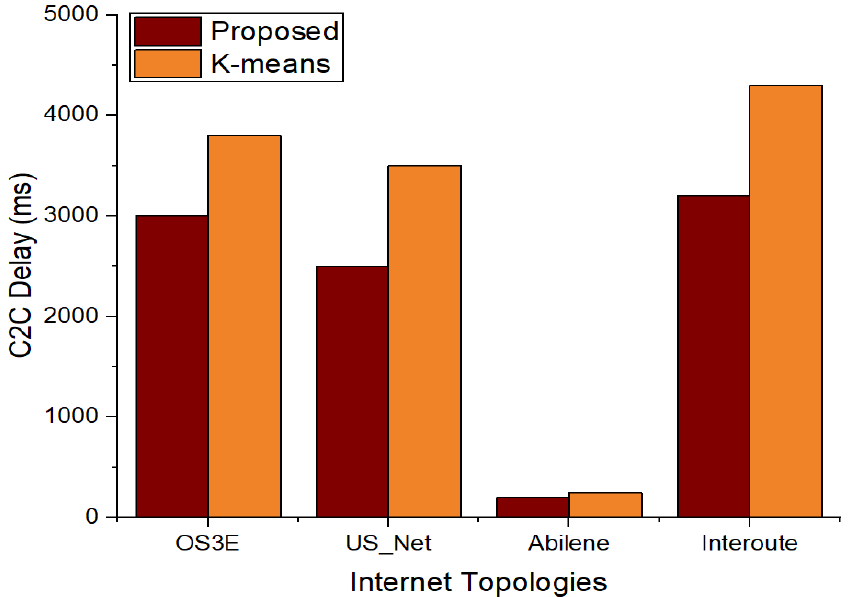
Figure 8. Comparison of C2C delay between proposed scheme and k-means with 6 clusters.